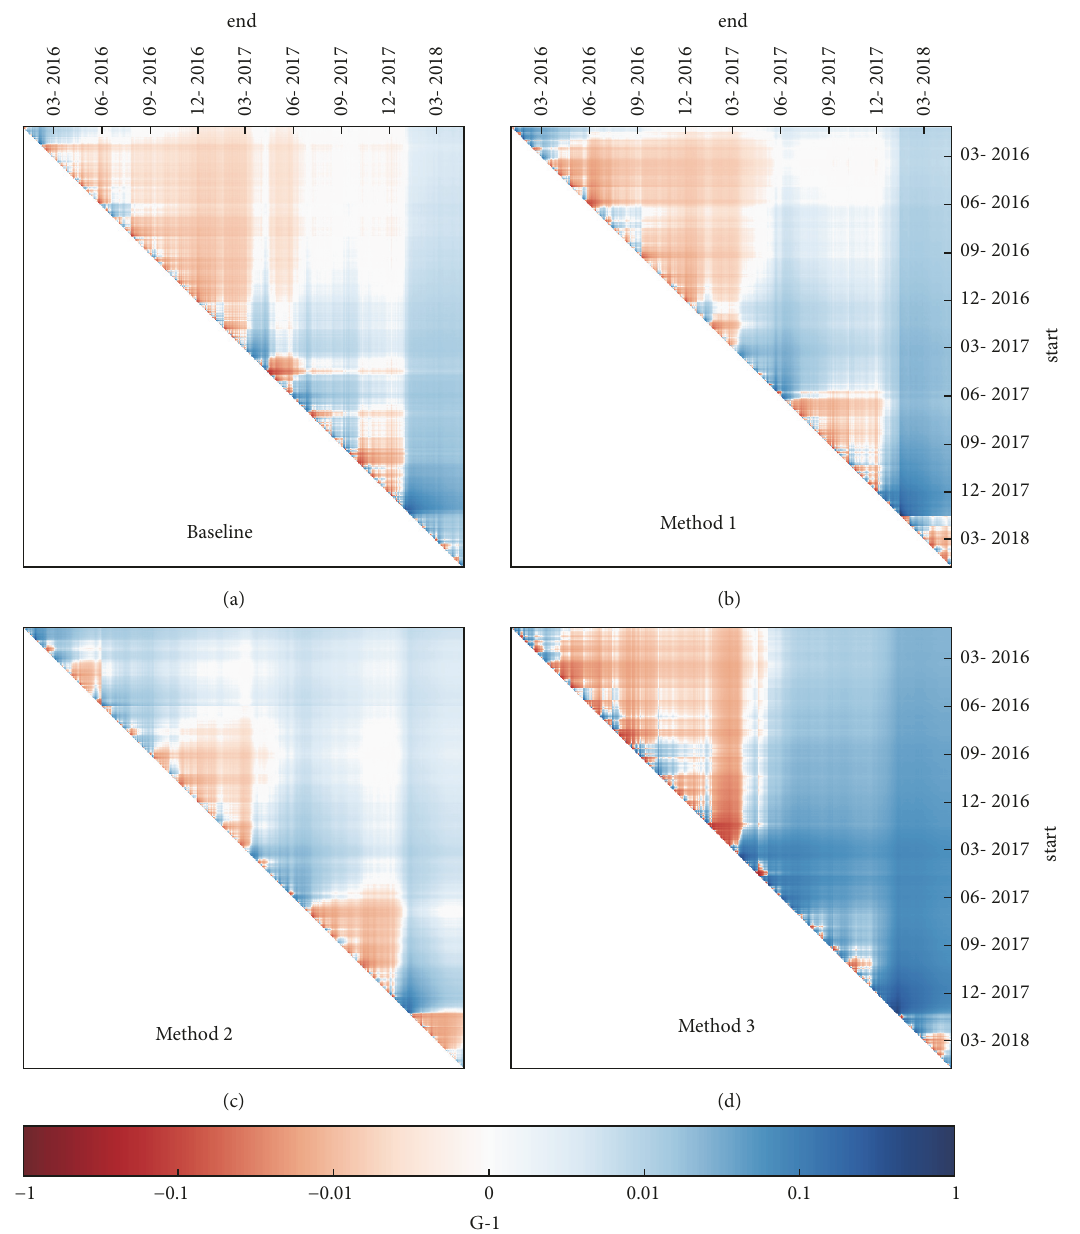
Figure 6: Geometric mean return obtained within different periods of time. The geometric mean return computed between time “start” and “end” using the Sharpe ratio optimisation for the baseline (a), Method 1 (b), Method 2 (c), and Method 3 (d). Note that, for visualization purposes, the figure shows the translated geometric mean return G-1. Shades of red refer to negative returns and shades of blue to positive ones (see colour